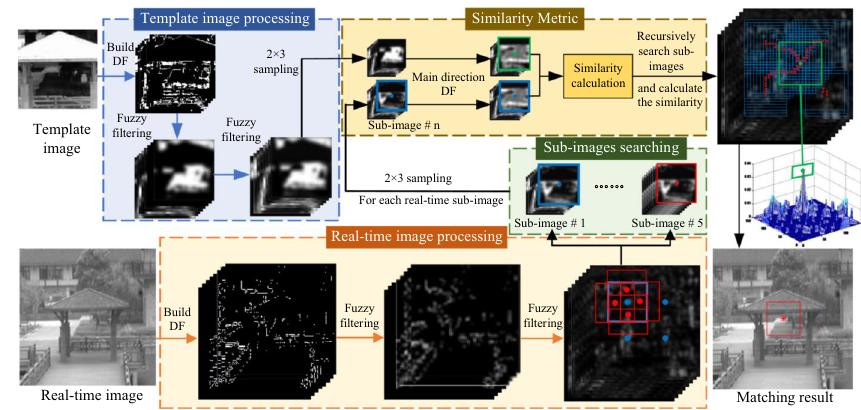
Fig. 1 Flowchart of the proposed method